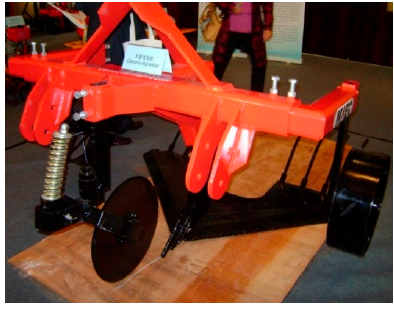
Figure 11. Menoble 3-point mounted 2-row potato planter (Photo: Brian Sims).